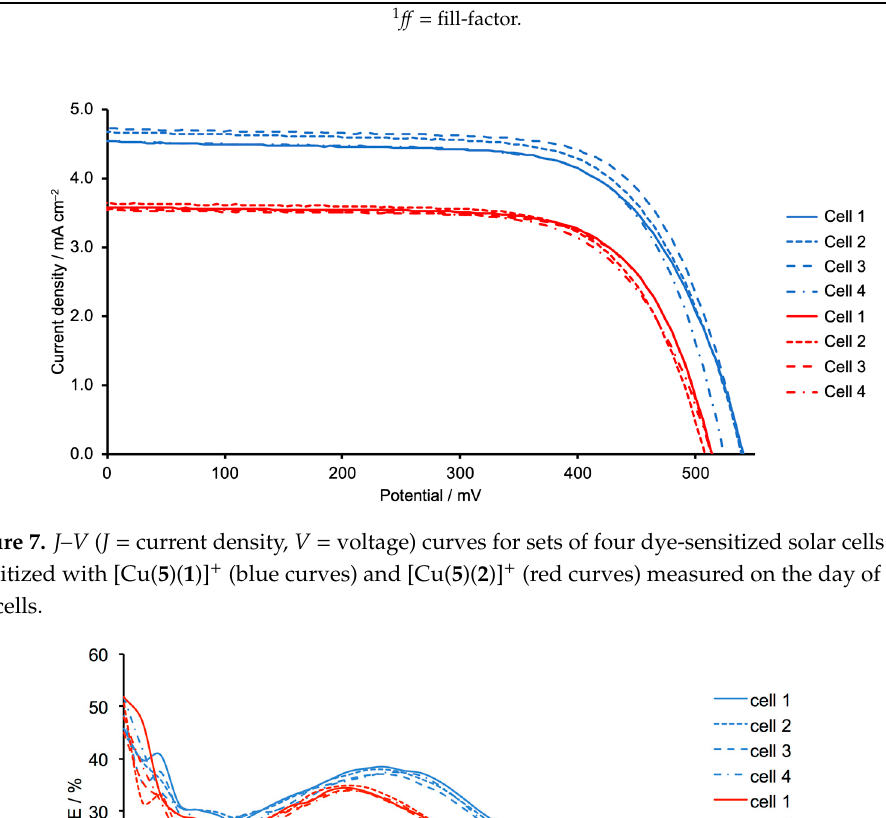
Figure 8. External quantum efficiency (EQE) spectra for sets of four DSCs sensitized with [Cu( 5 )( 1 )] + (blue curves) and [Cu( 5 )( 2 )] + (red curves) measured on the day of sealing the cells. A critical question is why the introduction of the alkynyl spacer into the dye leads to a blue- shifted EQE maximum (Figure 8) rather than the red-shift observed in the absorption spectra (Figures 3 and 6). This reveals that the injection of electrons into the semiconductor is not benefitting from an extension of light absorption towards longer wavelengths. It is informative to compare the performance data and EQE spectra for DSCs with [Cu( 5 )( 1 )] + and [Cu( 5 )( 2 )] + with those sensitized with [Cu( 5 )(dmbpy)] + where dmbpy is 6,6’-dimethyl-2,2’-bipyridine (Scheme 6). Using a common